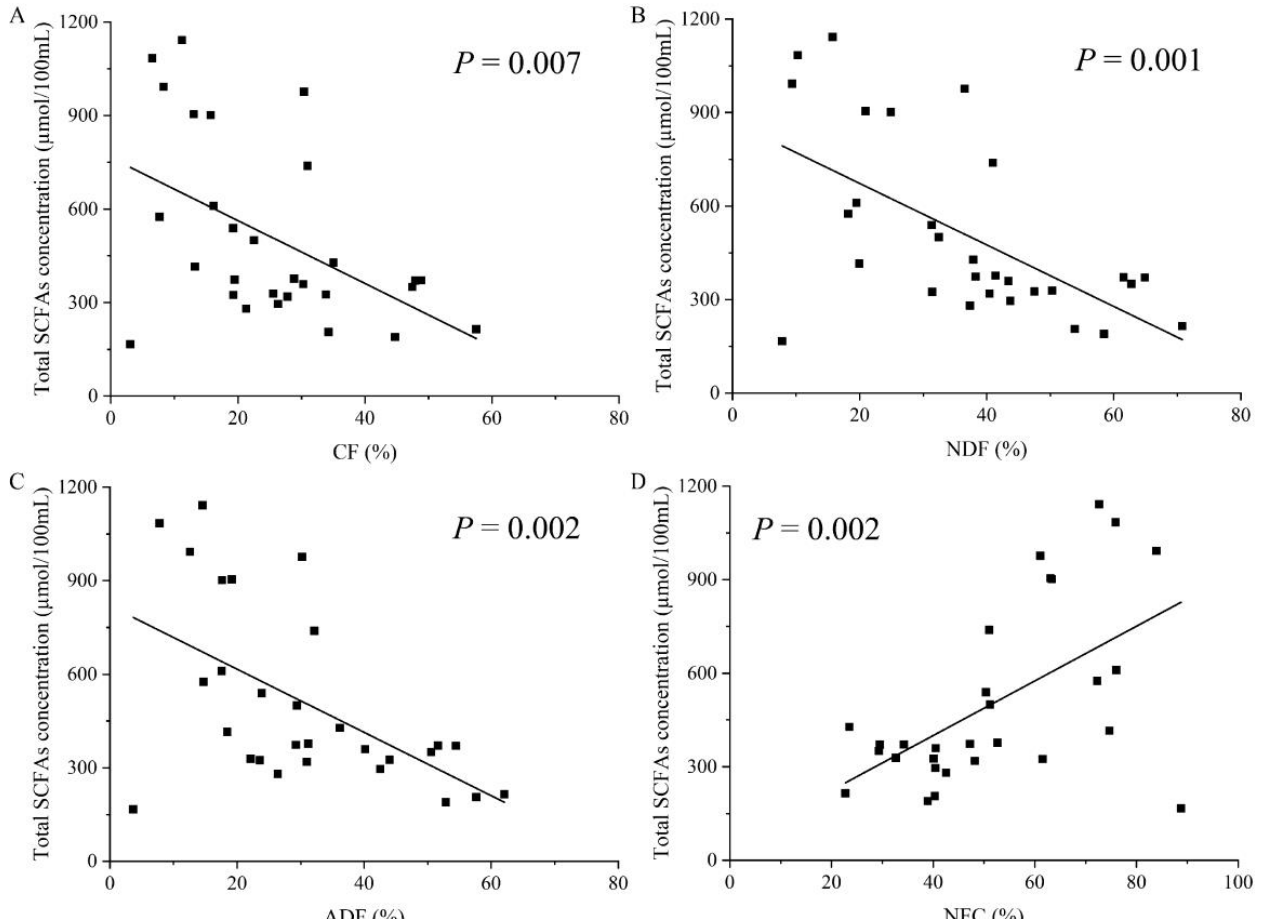
Figure 3. Correlation analysis of total short-chain fatty acids (SCFAs) concentrations with crude fiber (CF; ( A )), neutral detergent fiber (NDF; ( B )), acid detergent fiber (ADF; ( C )), and non-fiber carbohydrates (NFC; ( D )). p < 0.05 indicates significant correlation.